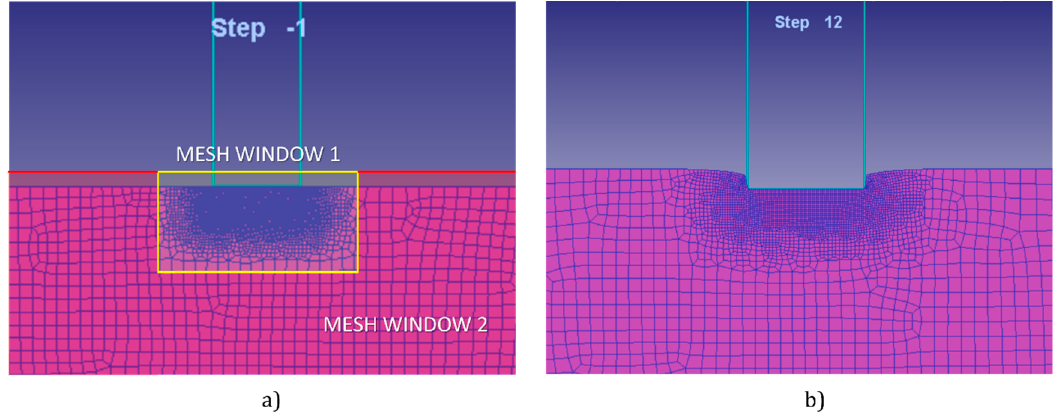
Figure 4. Mesh windows distribution: before indentation ( a ); and during indentation ( b ).